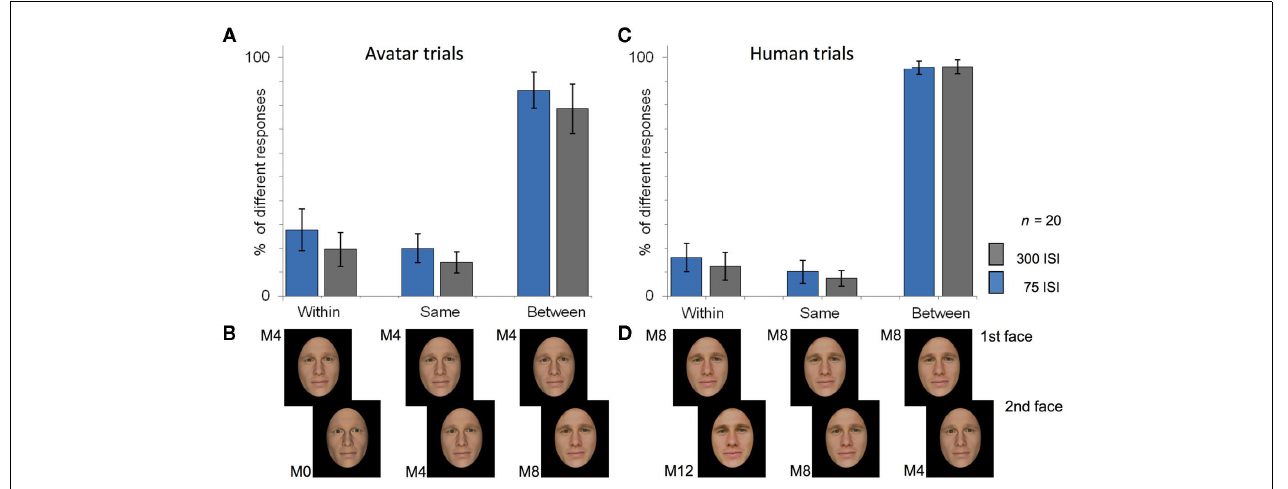
(B) and M4, M8, and M12 for human trials (D) : the first face in (B) is always M4 and in (D) always M8.The upper panels show the proportion of “different” responses for avatar (A) and human (C) trials across 20 participants. Controlling for relative distance of morphs along the continua, results show better discrimination accuracy for face pairs that crossed the category boundary (as determined in the forced choice classification task) than for pairs drawn from the same (avatar or human) side of the boundary, thus demonstrating categorical perception along our continua of human likeness for avatar and human